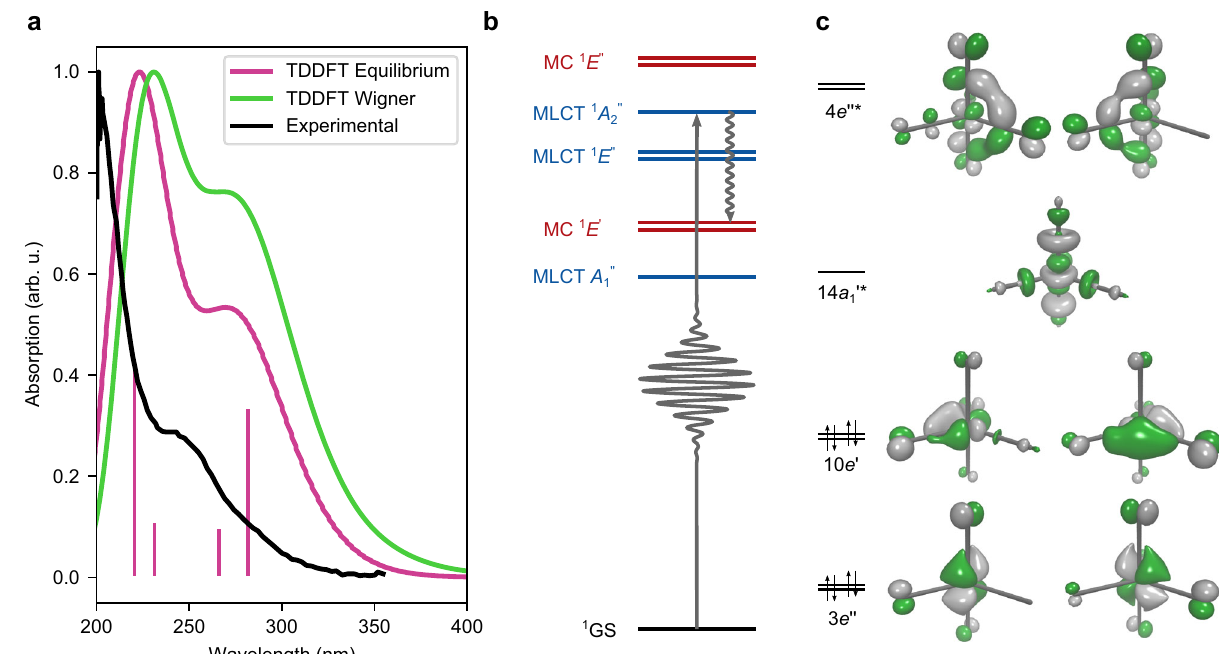
Fig. 1 Photoexcitation, energy levels and frontier molecular orbitals of ironpentacarbonyl Fe(CO) 5 . a The time-dependent density functional theory (TDDFT) simulated UV – vis spectra for the equilibrium geometry (pink curve) and the Wigner distribution (green curve), and the experimental gas-phase UV – vis spectrum reproduced from ref. 32 (black curve). The pink sticks correspond to the discrete TDDFT transitions at the equilibrium geometry. b Level diagram of electronic states involved in the photoexcitation and in the subsequent dissociation process. The character of metal-to-ligand charge-transfer (MLCT) and metal-centered (MC) states is denoted by red and blue color, respectively. c Frontier molecular orbitals involved in the photodissociation of ironpentacarbonyl, with speci fi cations of orbital symmetries and ground-state